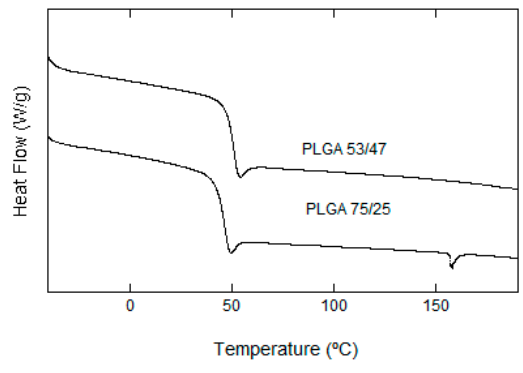
Figure 6. Thermograms of PLGA (53/47) and PLGA (75/25).